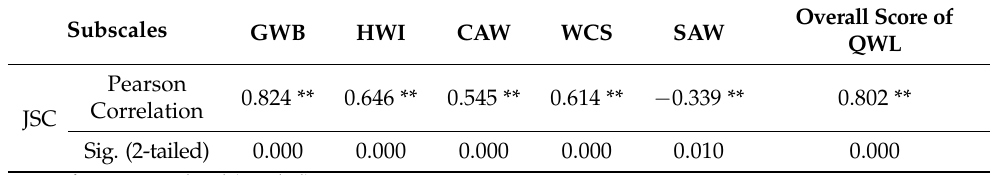
Table 4. Correlation Between QWL and JCS.